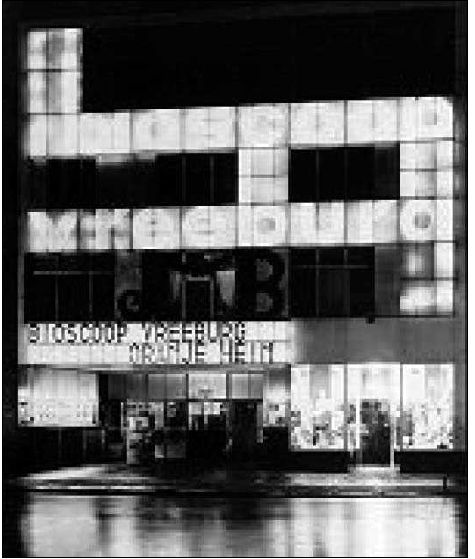
Fig. 9. “bioscoop Vreeburg” cinema (arch. Gerrit